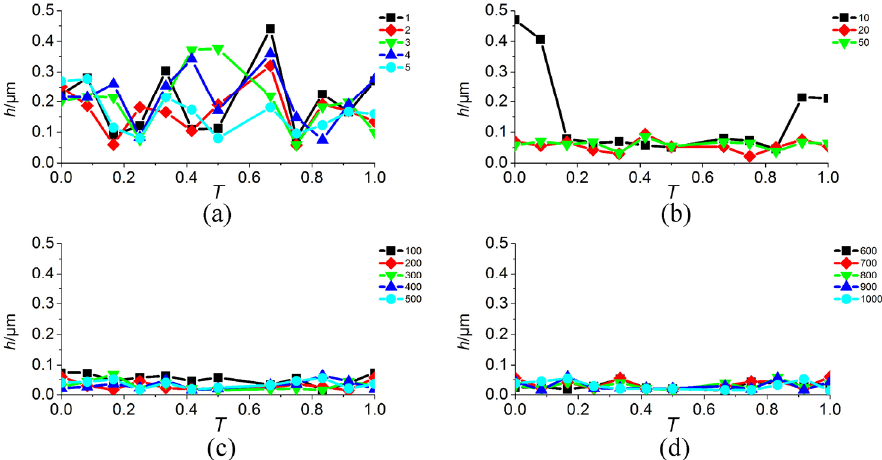
Fig. 14 Variation of central film thickness in some typical working periods ( v max = 0.01 m/s, w = 50 N, T = 0.5 s, L = 1.25 mm).